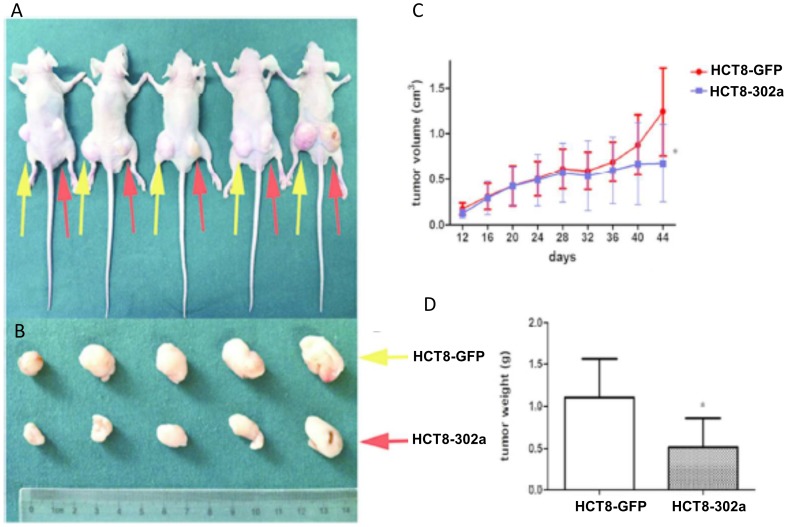
Overexpression of miRNA-302a significantly inhibits cell proliferation in colon cancer cells in vivo.HCT8-GFP cells and HCT8-302a cells were injected into the left and right posterior flank of nude mice, respectively (A, B). The tumor volume (C) and mass (D) in the HCT8-302a group were notably lower than in the HCT8-GFP group. (* P<0.05).